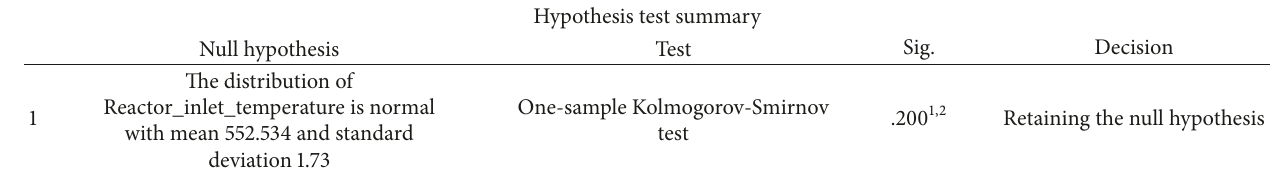
Table 12: Nonparametric tests summary of reactor inlet temperature.